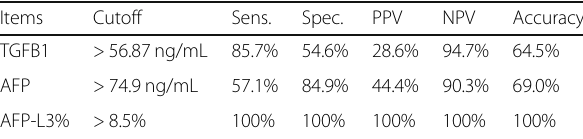
Table 5 Diagnostic performance of TGFB1, AFP, and AFP-L3% after radiofrequency ablation in the prediction of tumor recurrence Items Cutoff Sens. Spec. PPV